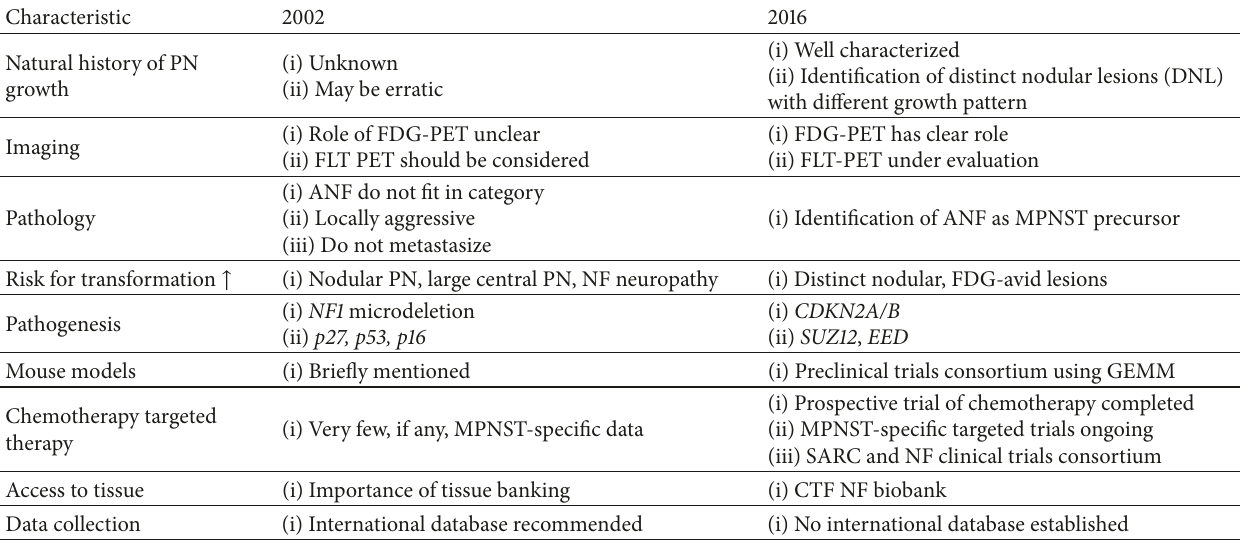
Table 1: Summary of progress in preclinical, clinical, and therapeutic MPNST research and clinical management since the 2002 international consensus